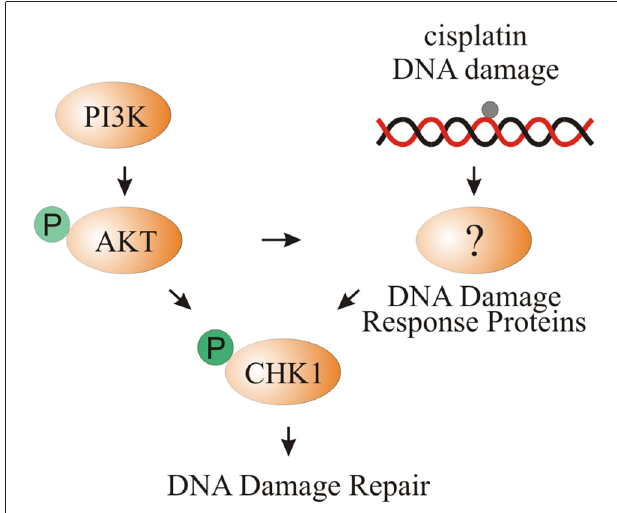
FIGURE 8 | Model of CHK1 phosphorylation through cisplatin damage and PI3K signaling. Activation of PI3K signaling either by bpV(HOpic) or Pten deletion results in increased AKT phosphorylation. DNA damage caused by cisplatin activates DNA damage response proteins that increase pCHK1 levels. Activated AKT can directly or indirectly increase pCHK1 levels by activating the DNA damage response proteins. Together, PI3K activation and cisplatin-induced DNA damage results in increased pCHK1 to promote supporting cell